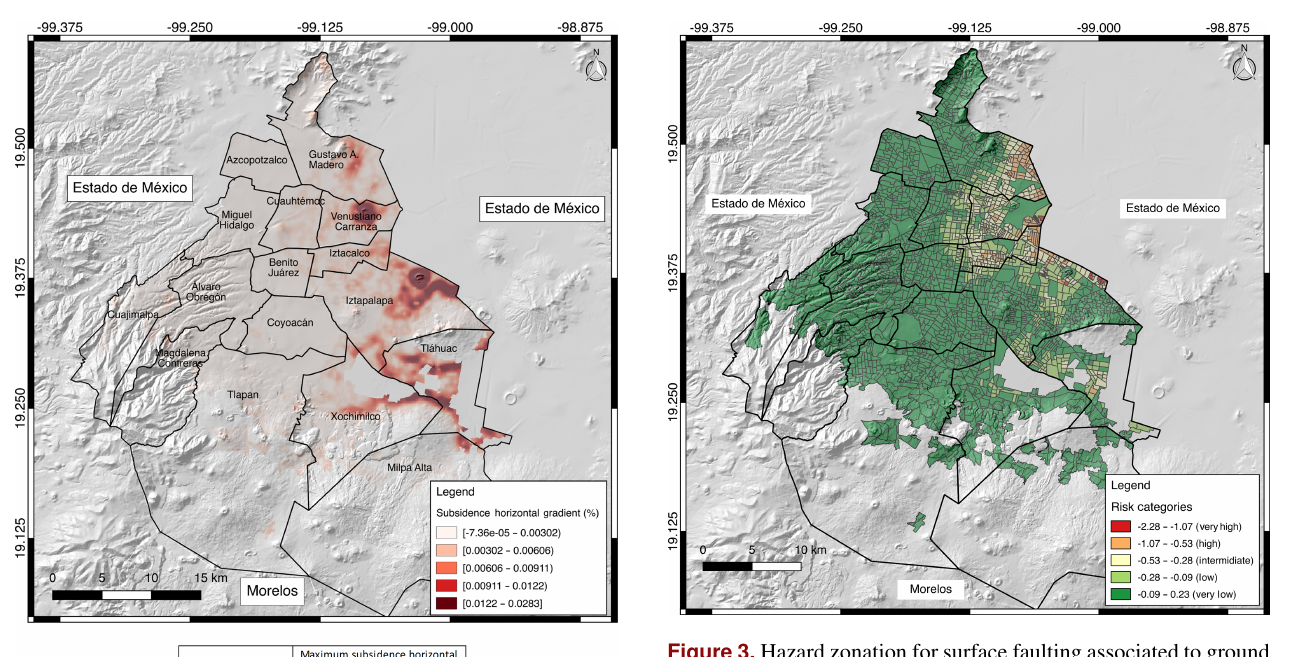
Figure 3. Hazard zonation for surface faulting associated to ground subsidence in the Mexico City. The shaded topographic base layer is taken from Continuo de Elevaciones Mexicano 3.0. © Instituto Nacional de Estadística Geografía e Informática